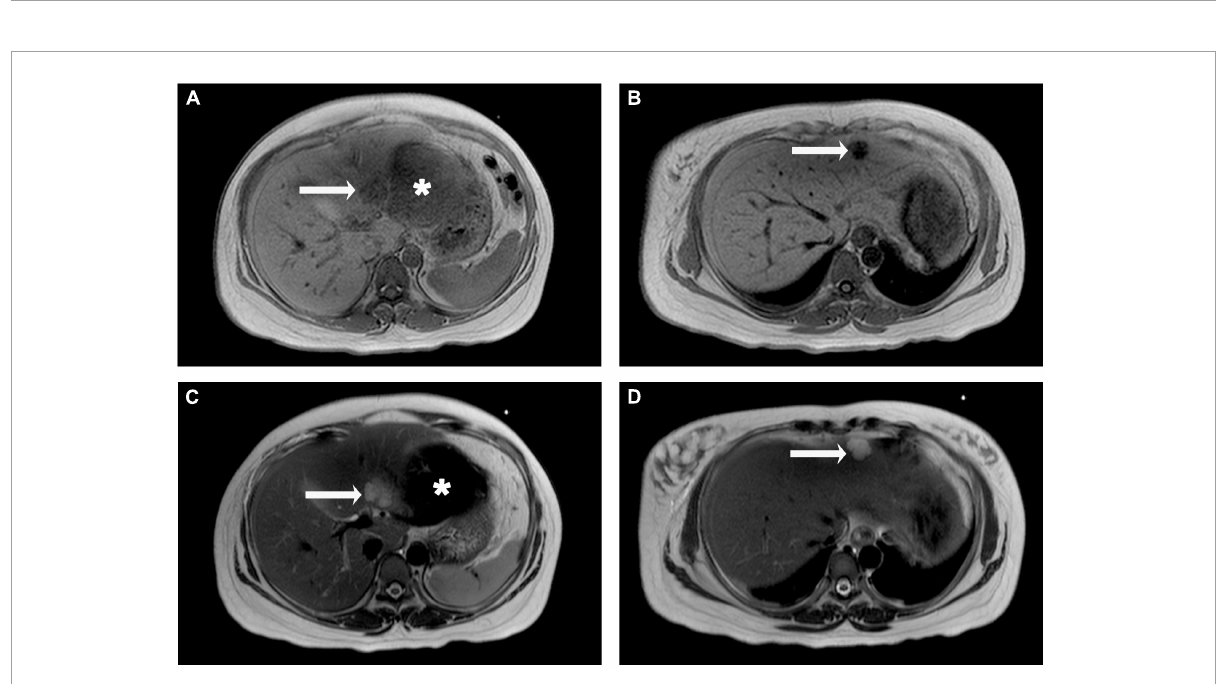
FIGURE2 Liver magnetic resonance imaging (MRI) plain scan observations. The lesions in segment III and II of the liver were hypointense on T1-weighted images (A,B, arrow ) , but hyperintense on T2-weighted image (C,D, arrow ) . A large area of slightly longer T1 and shorter T2 signals is seen below the left hepatic lobe (A,C, asterisk )